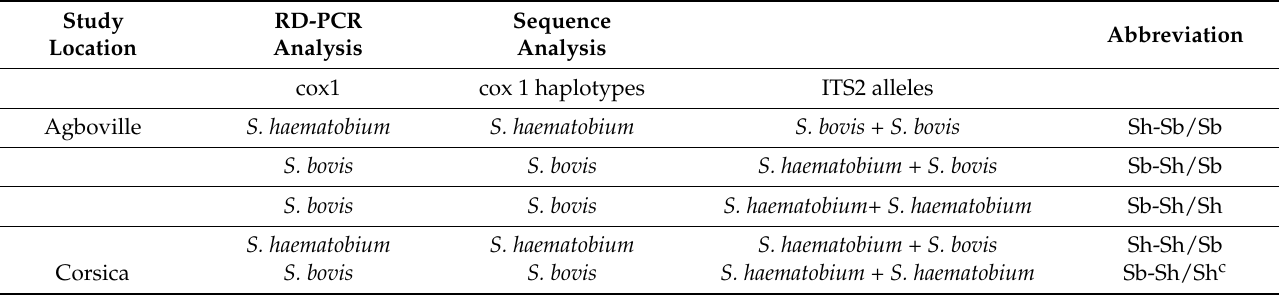
Table 1. Hybrid schistosomes genetic profiles according to the rapid diagnostic (RD-PCR) mitochondrial cox1 analysis and by sequencing of the cox1 and ITS regions, respectively, from studies in Agboville (C ô te d’Ivoire) and Corsica (c), France. The abbreviations Sb/Sb, Sh/Sb or Sh/Sh indicate that at the diagnostic sites two chromatogram peaks were visible after